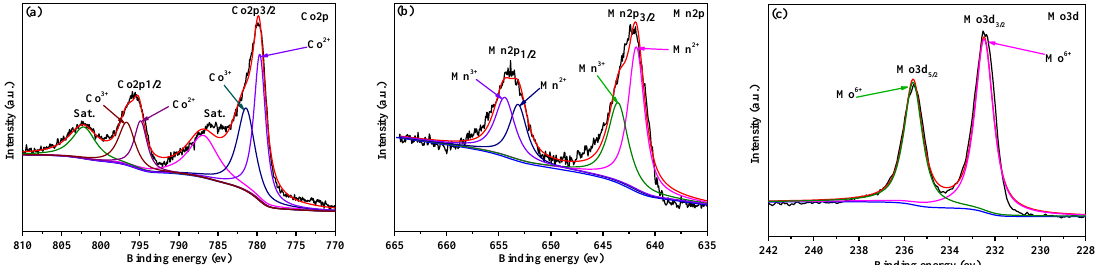
Figure 4. N 2 absorption-desorption isotherms of ( a ) MoO 3 -doped MnCo 2 O 4 (0), ( b ) MoO 3 -doped MnCo 2 O 4 (0.04), ( c ) MoO 3 -doped MnCo 2 O 4 (0.10), and ( d ) MoO 3 -doped MnCo 2 O 4 (0.12) (inset: Pore size distribution).